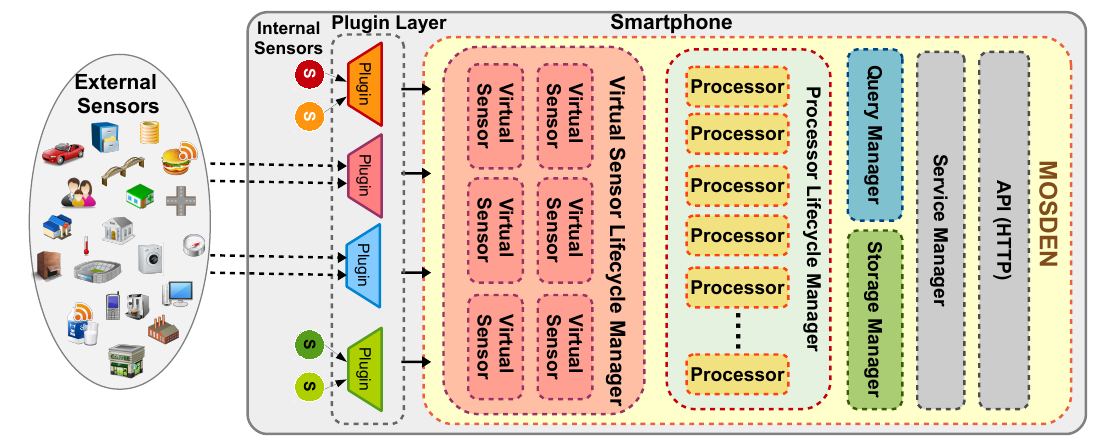
Figure 2. MOSDEN Platform